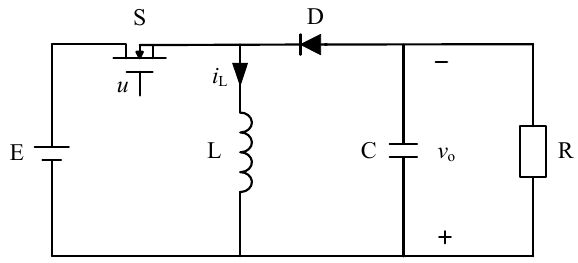
Figure 1. Circuit structure of the buck-boost